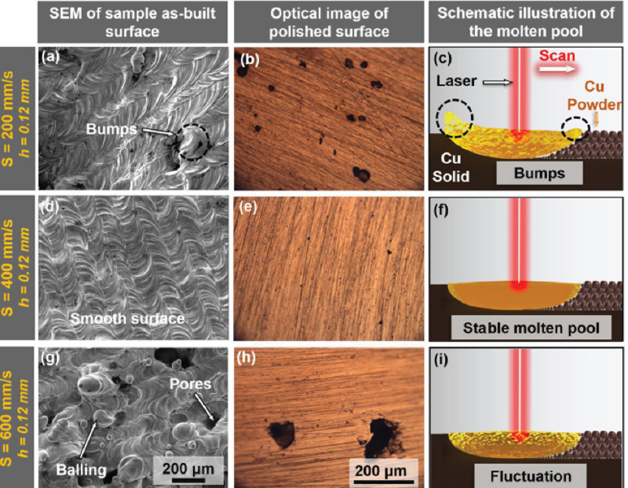
Figure 13. ( a , d , g ) SEM micrographs of as ‐ built surface sand ( b , e , h ) optical images of polished surfaces with scan speeds of 200, 400, and 600 mm/s, respectively, and ( c , f , i ) schematic illustrations of the molten pool shapes at different laser scan speeds. Reproduced with permission from [13] Elsevier, 2020.